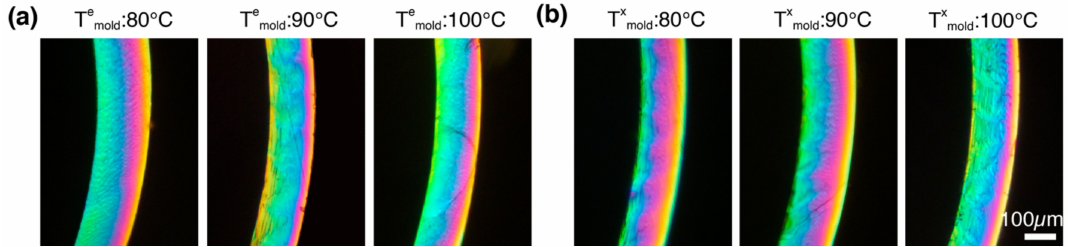
Figure 9. Expanded tubes stretched at: ( a ) T e mold = 80, 90 and 100 ◦ C (Figures 3 and 4a); and ( b ) T x mold = 80, 90 and 100 ◦ C were extracted from the instrument and microtomed parallel to the (r, θ ) plane to yield consecutive 50 µ m thick circular cross sections. The 50 µ m sections were sandwiched between glass slides and imaged through linear crossed polarizers. Note that the sequence of Michel Levy colors from blue green to purple to pink to orange to yellow unambiguously shows that the retardance decreases from ID to